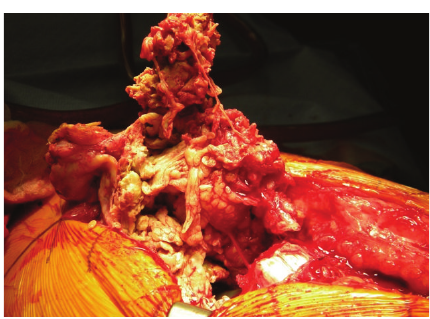
Figure 5: Revision surgery.